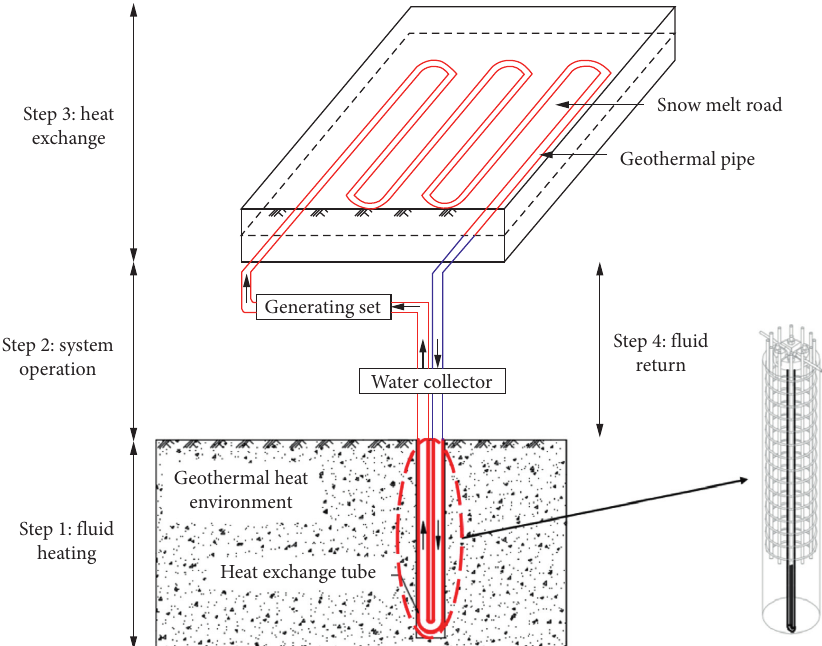
Figure 4: Flow chart of the model